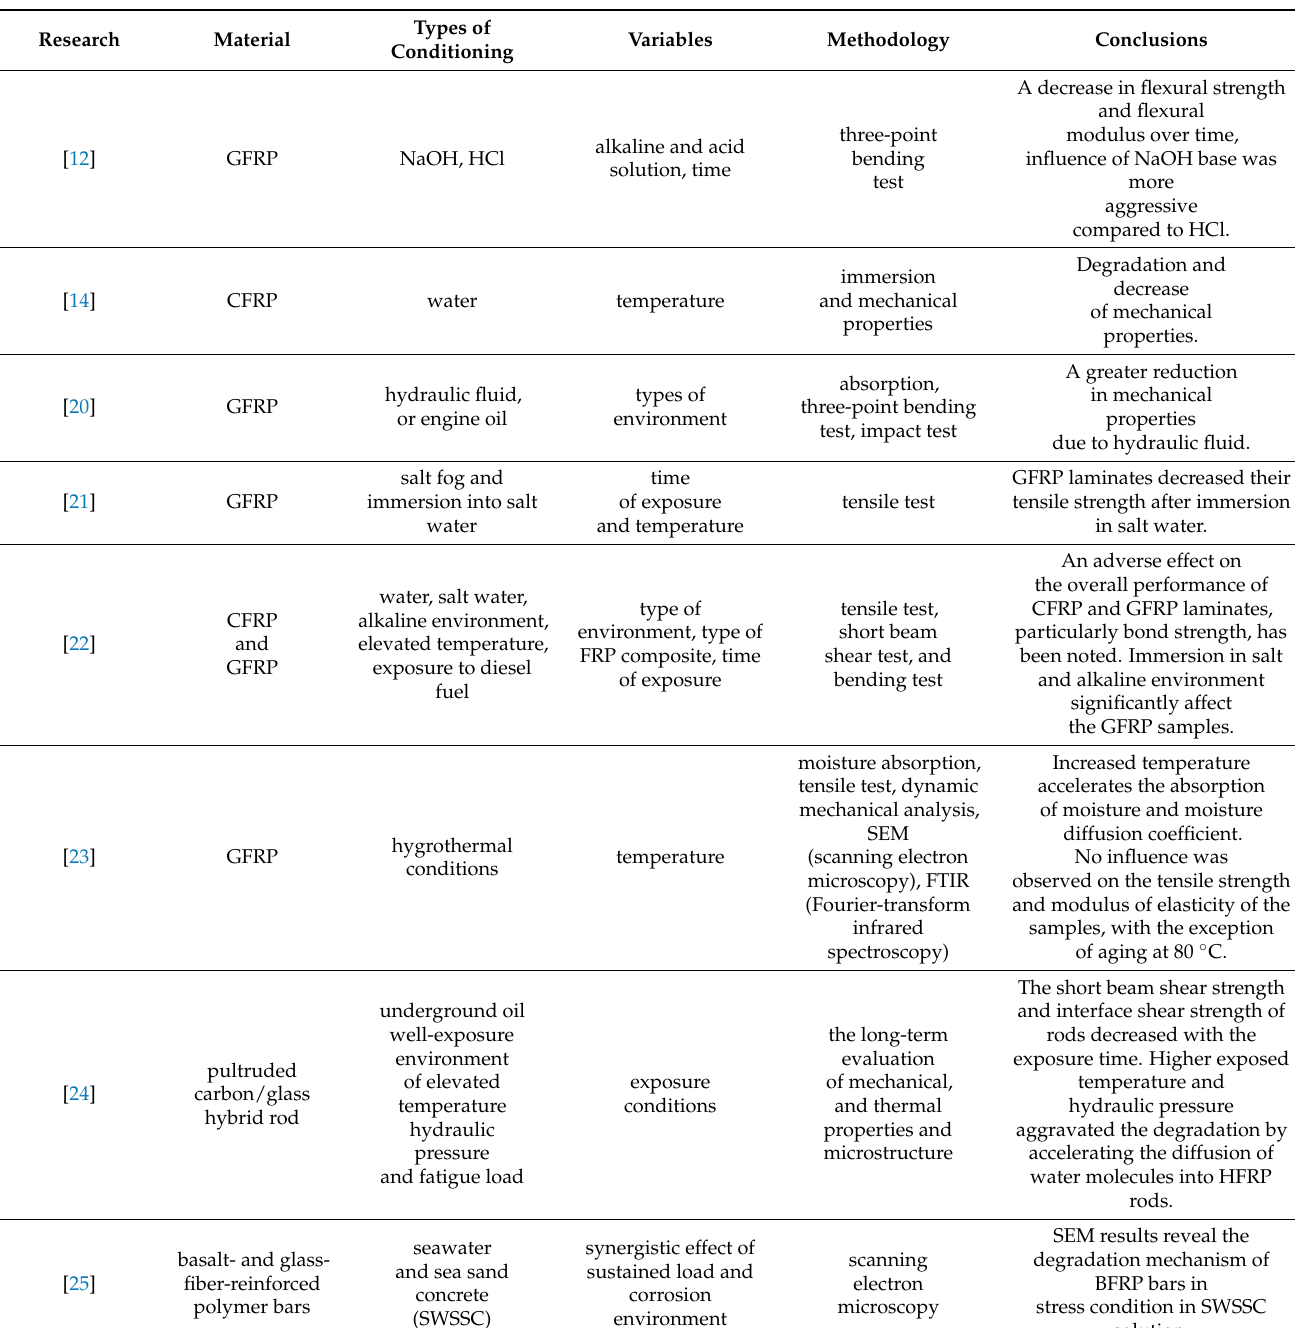
Table 1. Examples of conducted research on the influence of chemical environments and humidity on